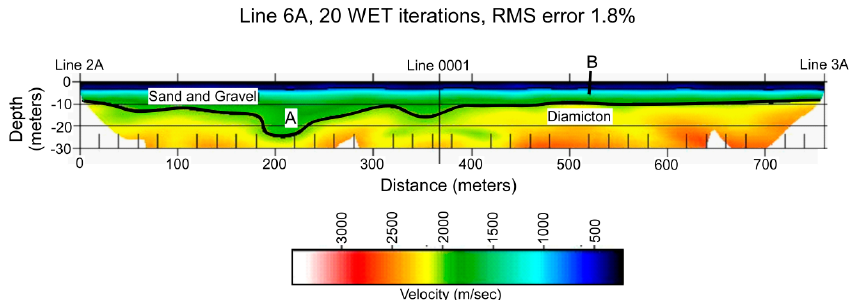
Figure 14. Seismic velocity profile of Line 6A. A = main channel, B = terrace.